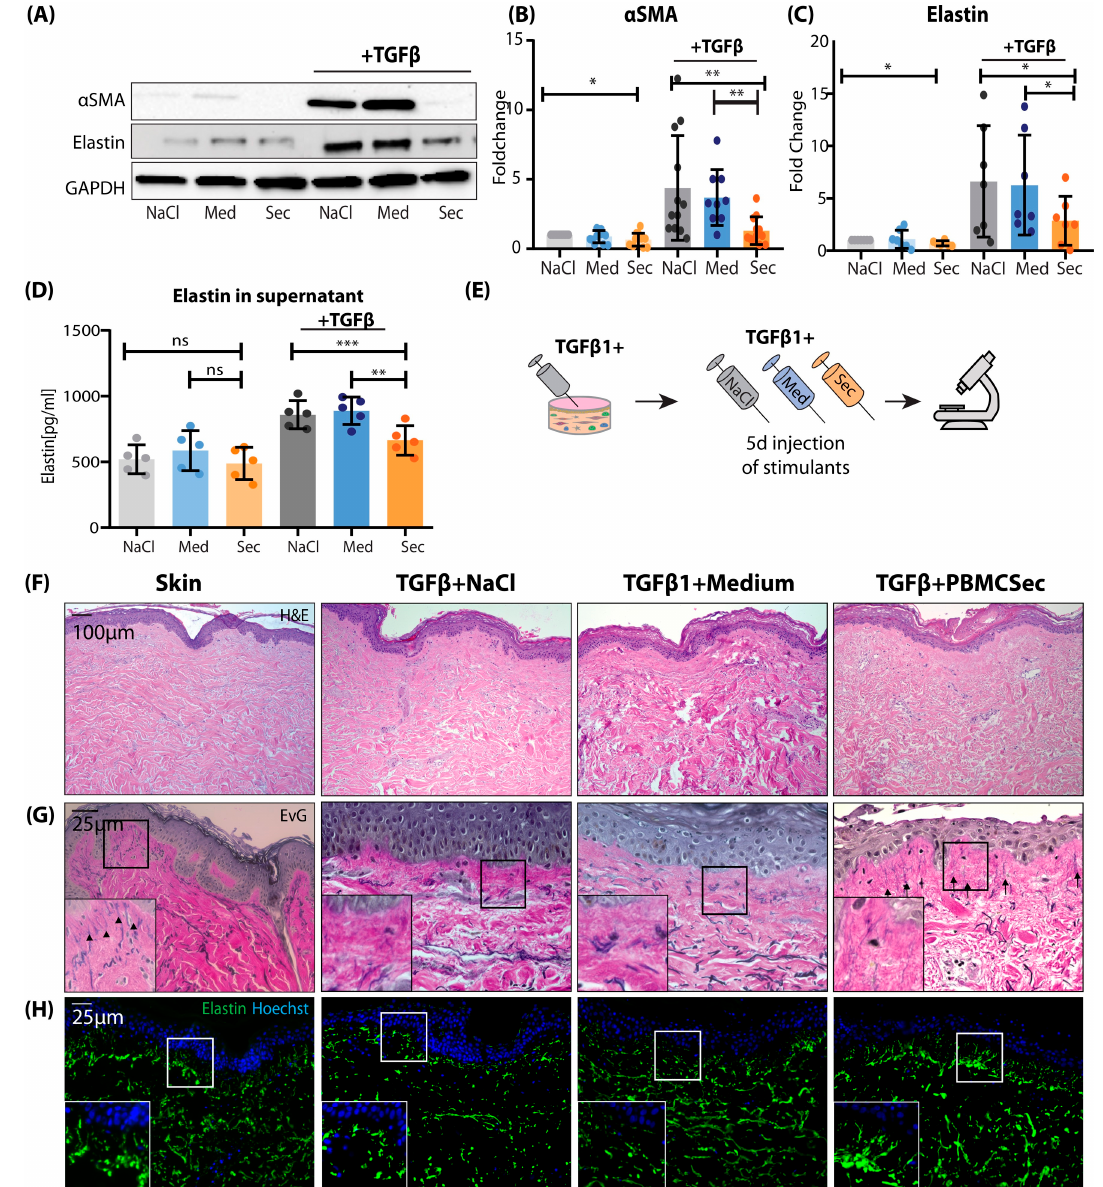
Figure 5. PBMCsec abolishes myofibroblast differentiation in vitro. ( A ) Western blot stained for alpha Smooth muscle actin (SMA) and elastin, and lysate from human primary FBs stimulated with NaCl, medium, or PBMCsec, without or with TGFß1, respectively. ( B ) Quantification of Western blot, normalized to ctrl (n = 6 human donors). ( C ) Elastin measured with ELISA from primary human FB supernatant, stimulated with NaCl, medium, or PBMCsec, without or with TGFß1. ( D ) Workflow illustration of ex vivo human skin TGFß stimulation experiment, where 5 mm skin biopsies were injected with TGFß and NaCl, medium, or PBMCsec for 5 consecutive days ( E ). ( E , F , H ) Elastica van Gieson. ( G ) Immunofluoresence staining for elastin in human ex vivo skin samples. Statistical significance was tested using one-sided ANOVA. Lines and error bars indicate means and standard deviation. ns p > 0.05, * p < 0.05, ** p < 0.01, and *** p <